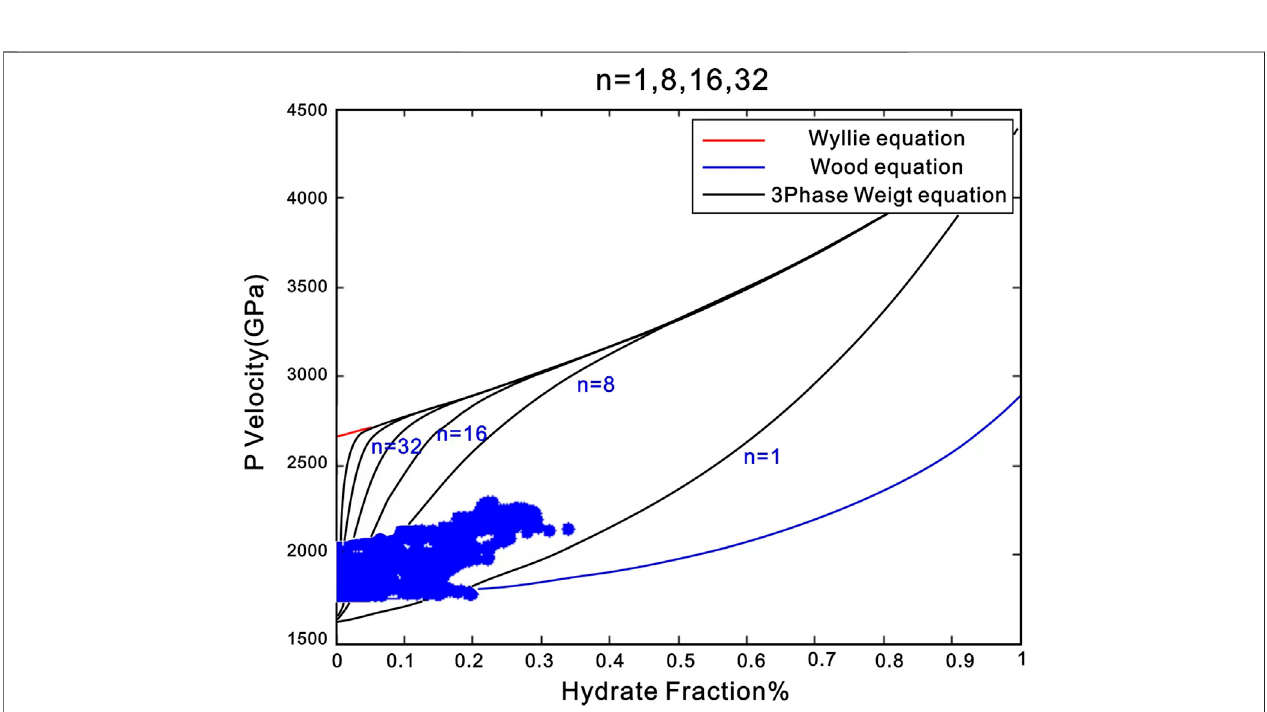
FIGURE 2 | Relation between the velocity obtained from the three-phase weight equation and hydrate saturation.